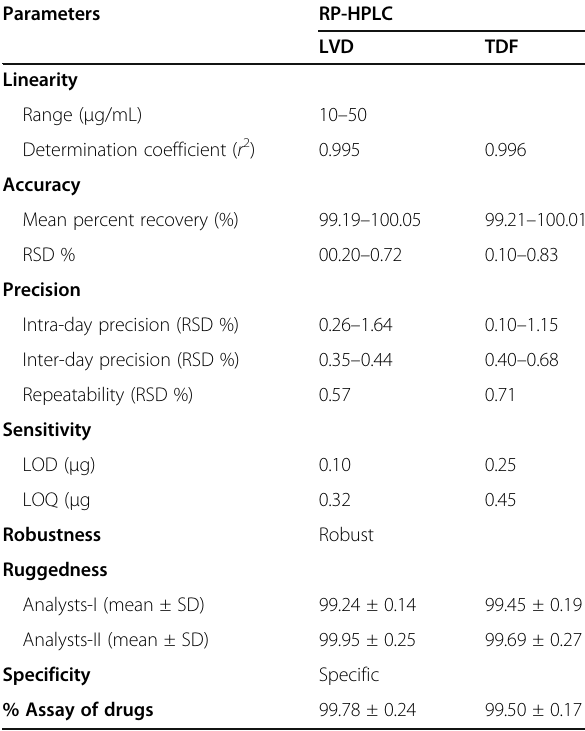
Table 5 Summary of validation parameters for proposed